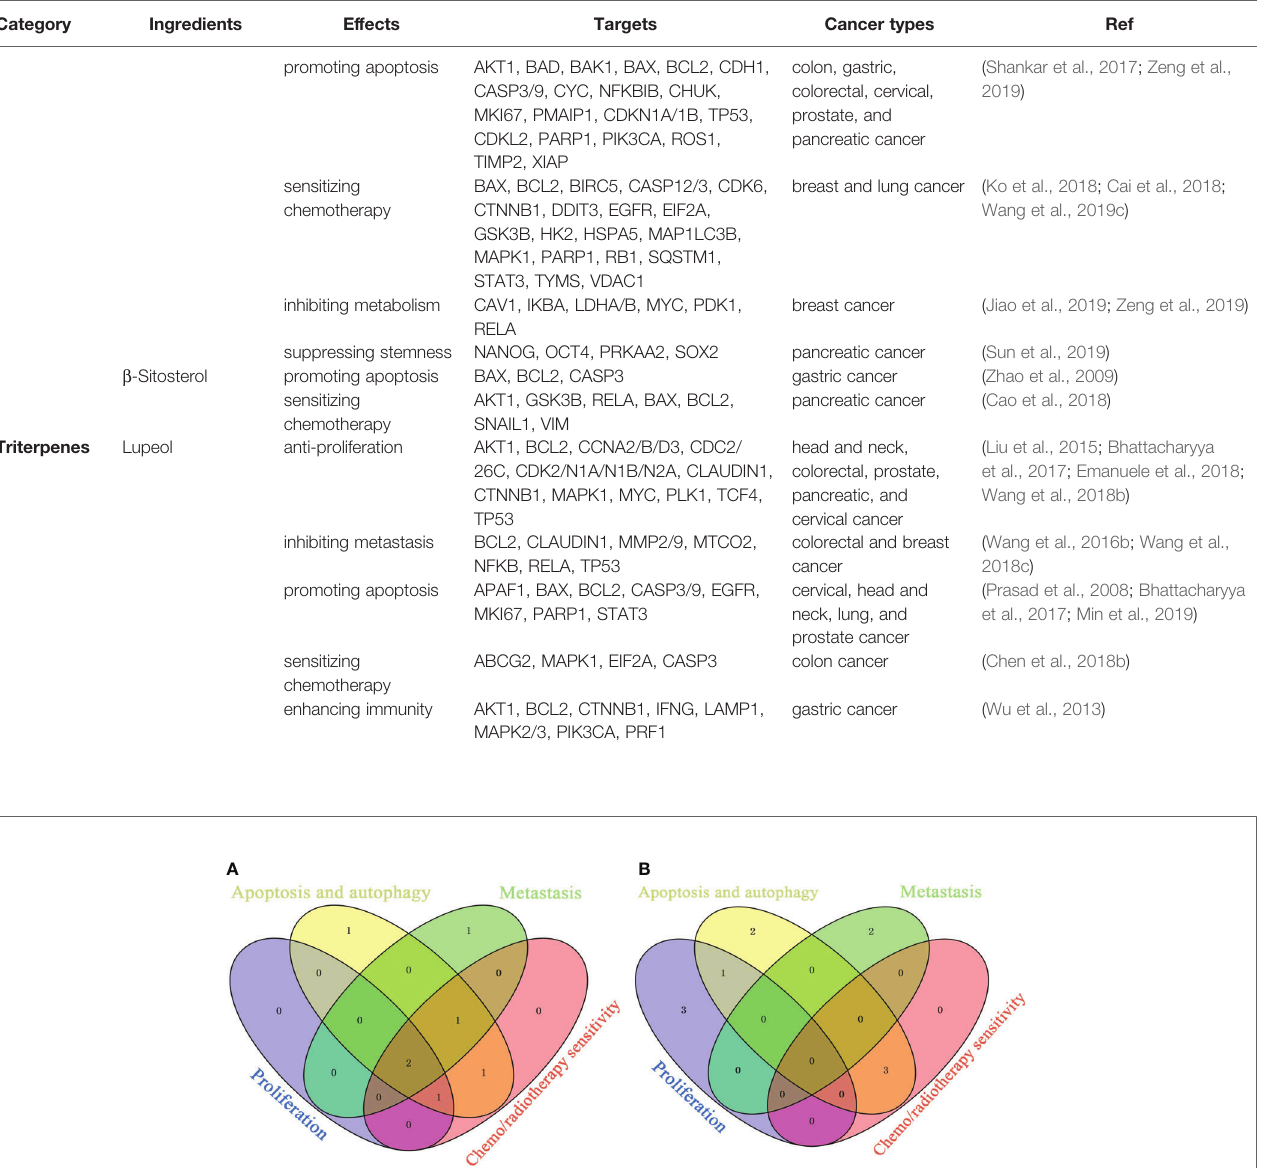
FIGURE 6 | Overlaps of Top Ingredients and Targets Related to Anti-Proliferation, Inducing Apoptosis and Autophagy, Inhibiting Metastasis and Sensitizing. (A) Top ingredients. (B) Top